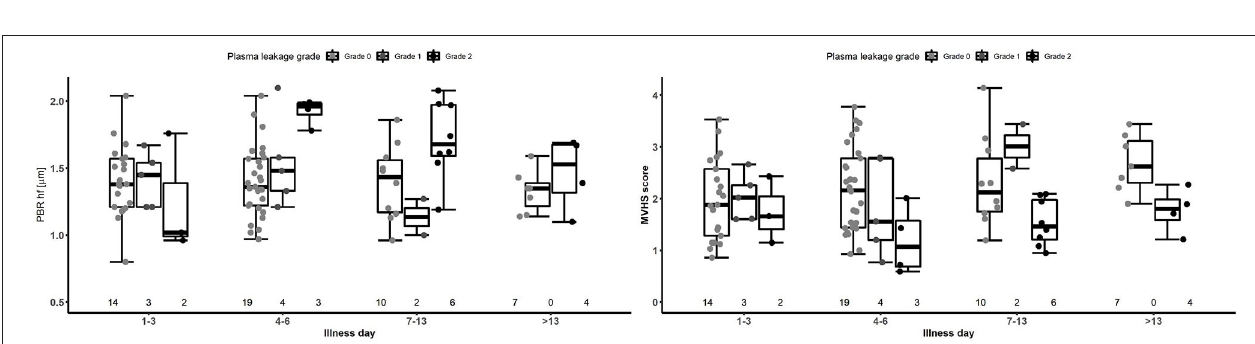
FIGURE 2 | Boxplot of perfused boundary region and microvascular health score by disease phase in patients with dengue versus OFI. The short black line indicates the median value in each disease phase. The graph is based on 34 outpatients (26 dengue and 8 OFI) contributing 79 measurements. The numbers at the bottom of the graph indicate the number of patients in each group. PBR hf, Perfused Boundary Region high flow; MVHS, MicroVascular Health Score; OFI, Other Febrile Illness.